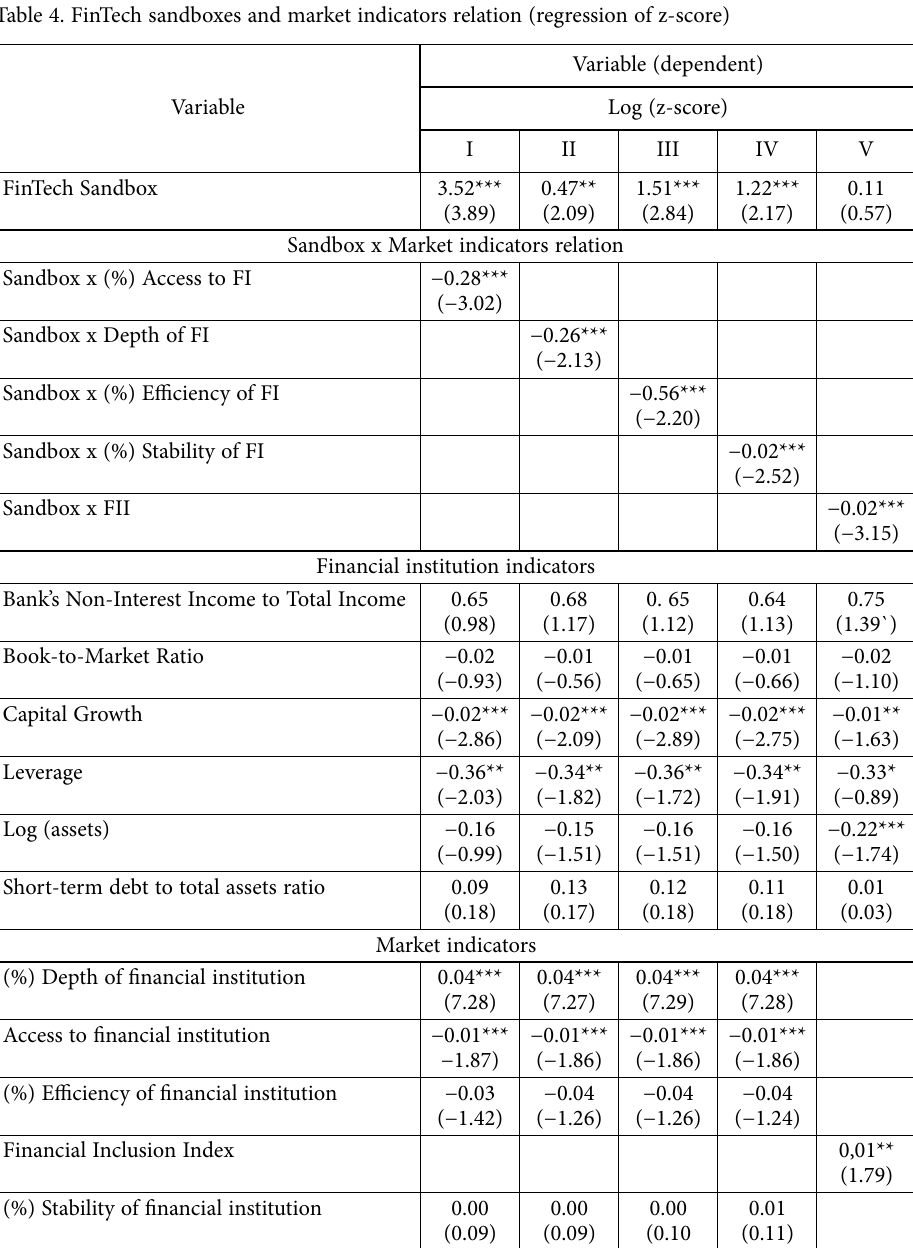
Table 4. FinTech sandboxes and market indicators relation (regression of